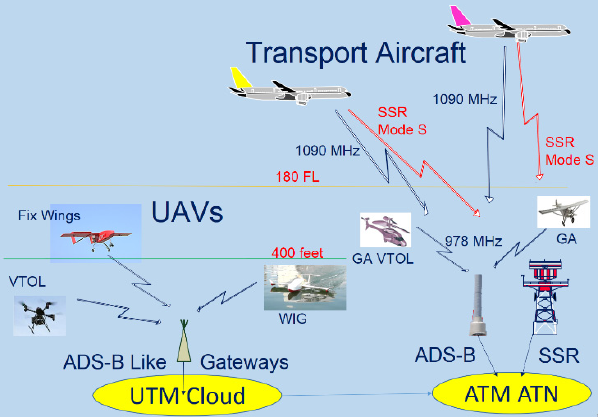
Figure 1. Surveillance concept for unmanned aerial systems traffic management (UTM) to air traffic management (ATM). Aerospace 2020 , 7 , x FOR PEER REVIEW